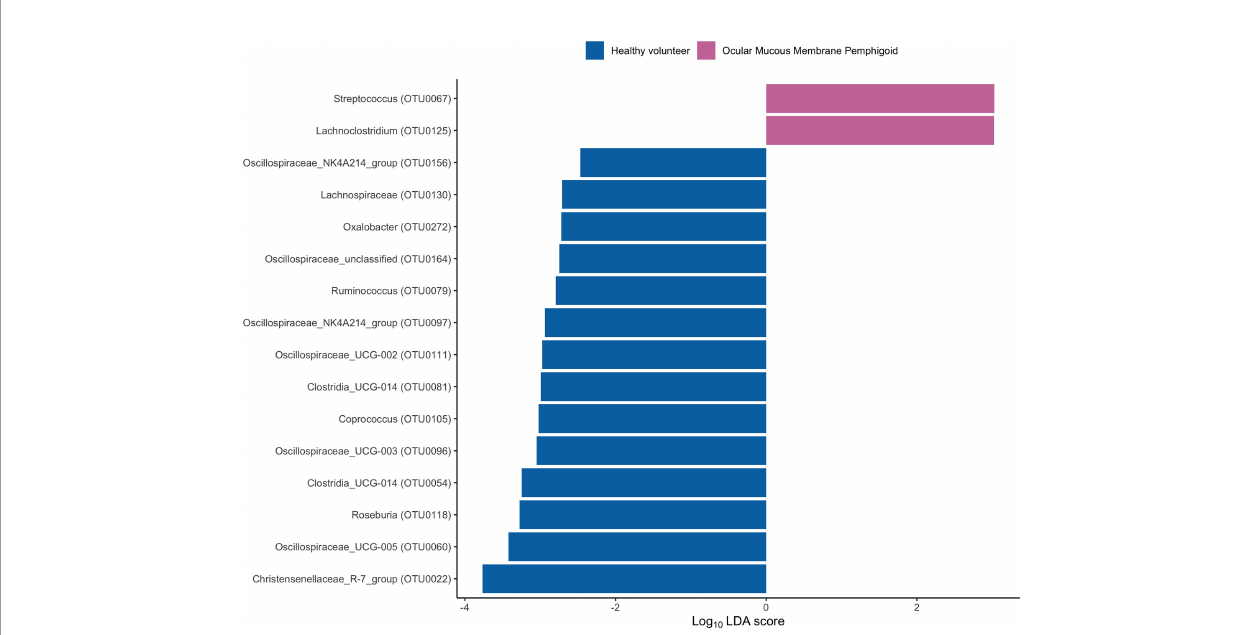
FIGURE 3 | Linear discriminant analysis (LDA) effect size (LEfSe) of signi fi cantly enriched bacterial taxa in OcMMP and healthy volunteers.